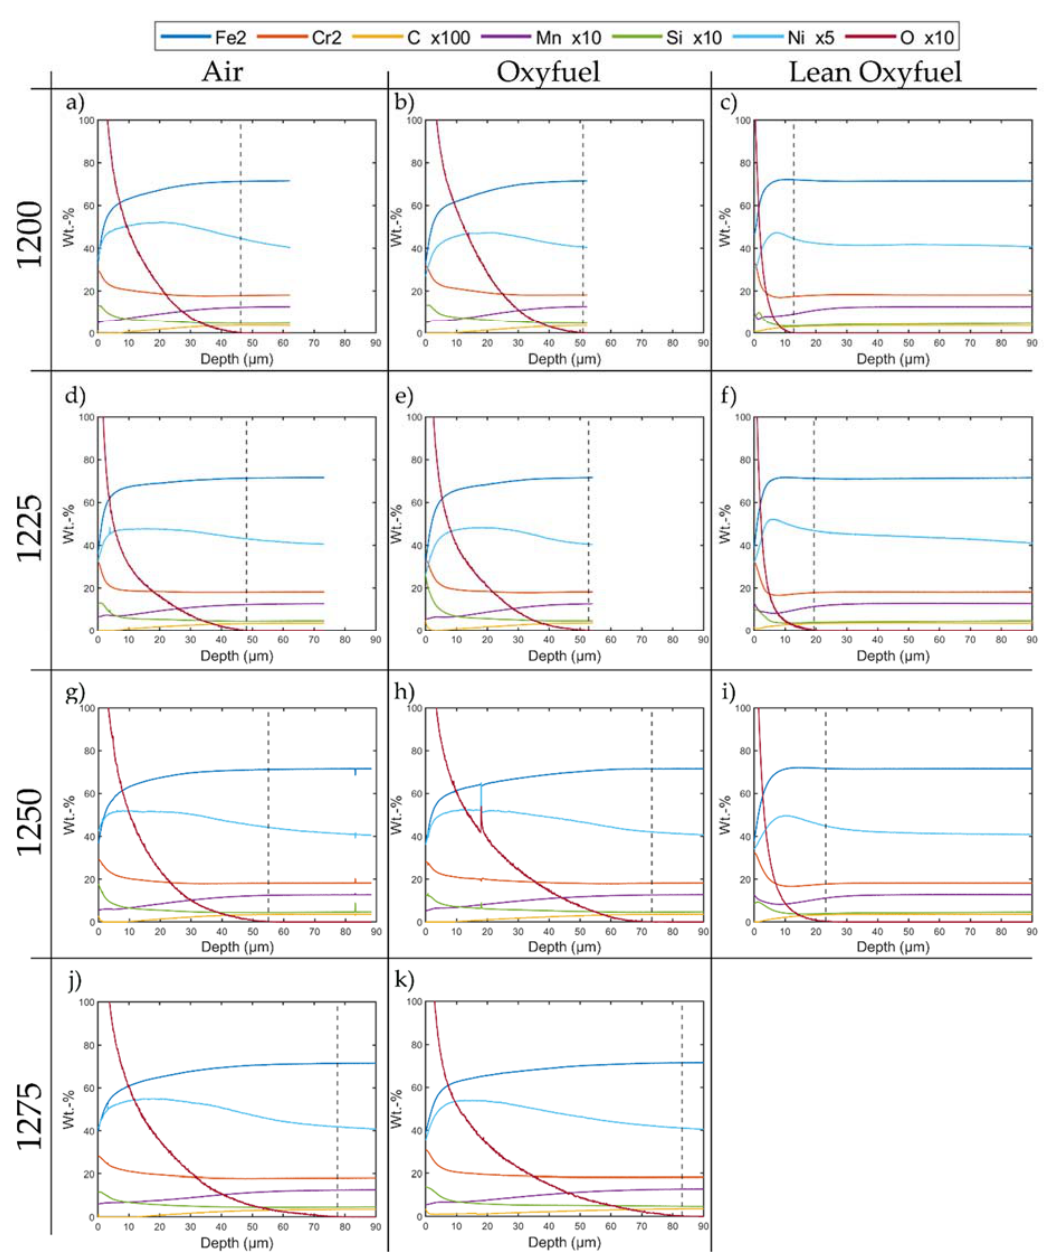
Figure 7. The GDOES depth charts in wt. % from sample surface towards the substrate metal for samples at 1200 °C in ( a – c ), 1225 °C in ( d – f ), 1250 °C in ( g – i ) and 1275 °C in ( j – k ). The x ‐ and y ‐ axis ranges are constant between the images, as well as the increase in values of carbon by 100 times, Mn by 10×, Si by 10× and Ni by 10×. From left to right in a single row, the order is always air, oxyfuel and lean oxyfuel atmosphere GDOES results. The vertical line in the smaller figures indicates the depth where the substrate begins.